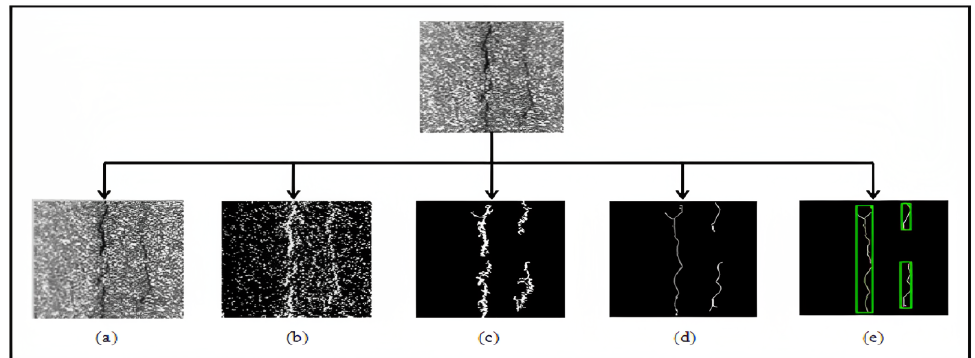
Figure 15. Location of the crack: ( a ): Original image; ( b ): Binarized image; ( c ): Denoising of the binarized image; ( d ): Skeletonization; ( e ): Crack